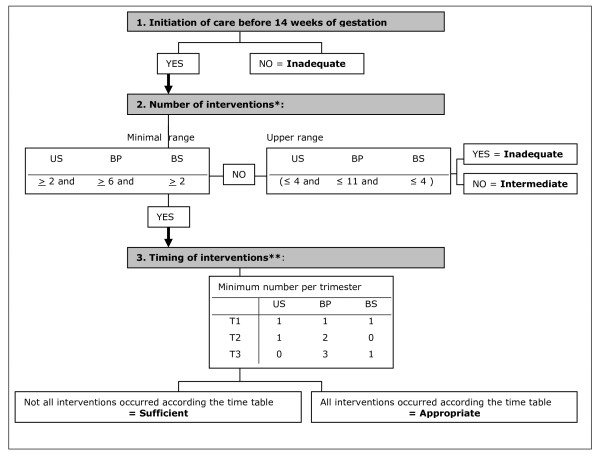
outline of the Content and Timing of care in Pregnancy (CTP) tool. US: Ultrasound, BP: Blood Pressure, BS: Blood Screening, T: Trimester. *Ranges: lower value based on the NICE [42] and Belgian guideline [40], upper value based on national data[50]. **based on the NICE[42]. Inadequate: initiation of care after first trimester OR the number of at least one intervention is less than the lower range and none of the interventions occurred more than the range. Intermediate: initiation of care in the first trimester; the number of at least one intervention occurred less than the lower range and at least one intervention exceeded the range. Sufficient: initiation of care in the first trimester; the number of all interventions equals at least the respective lower range but timing of at least one intervention is not as recommended. Appropriate: initiation of care in the first trimester; the number of the interventions equals at least the respective lower range and timing of the actions of all basic interventions is as recommended